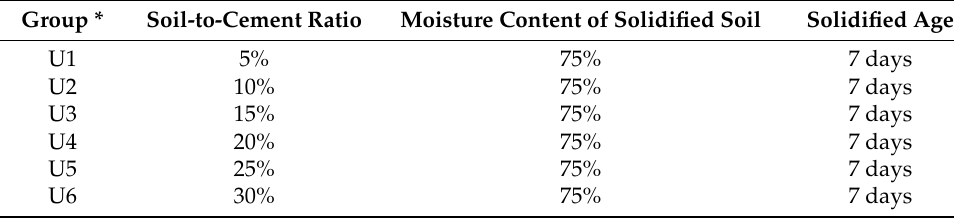
Table 3. UCT testing scheme for the solidified soil. Group * Soil-to-Cement Ratio Moisture Content of Solidified Soil Solidified Age